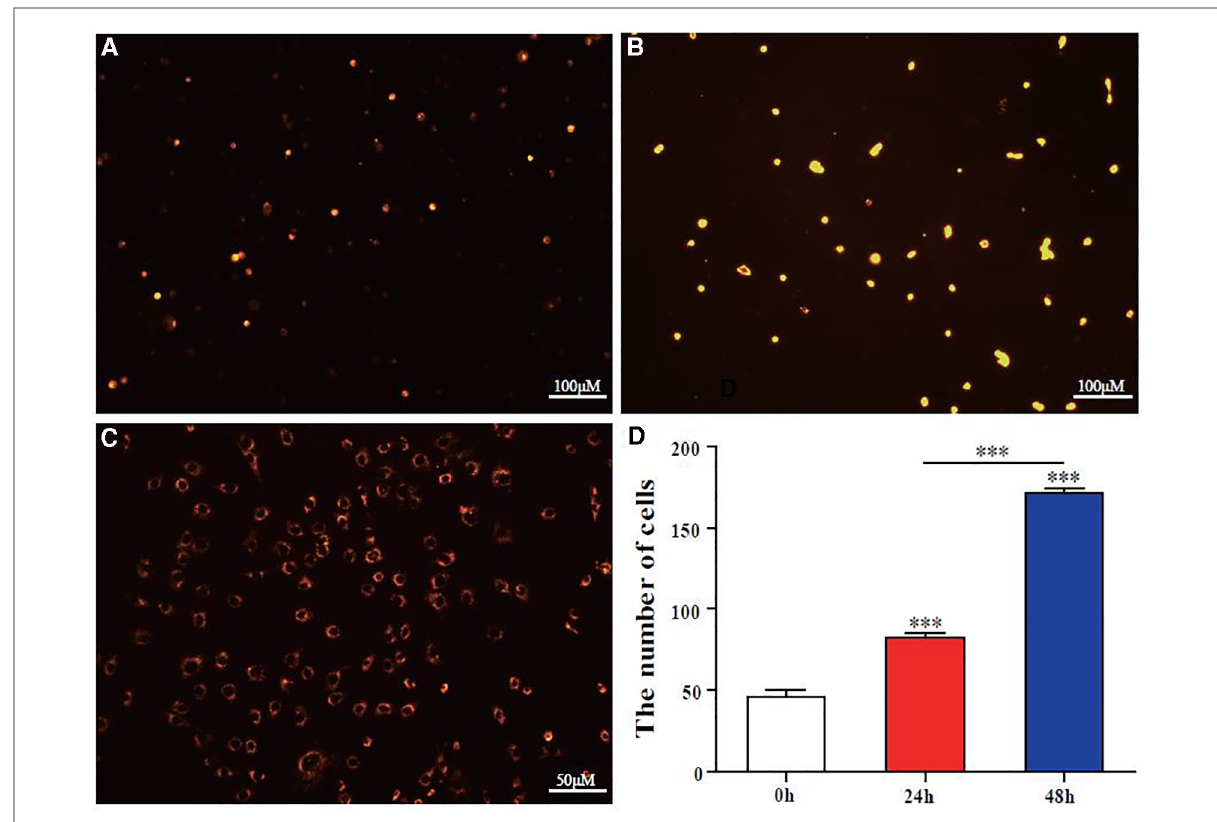
FIGURE 2 CM-Dil labeling of BMSCs and detecting proliferation in vitro . ( A – C ) At 0, 24, and 48 h, BMSCs were labeled by CM-Dil (red fl uorescence; bar scales= 100 μ M ( A,B ) Bar scales=50 μ M ( C )). ( D ) Quantitative analysis of BMSC proliferation in the DADM at 0, 24, and 48 h by cell count. Error bars represent SEM ( n =3), *** P ≤ 0.001.